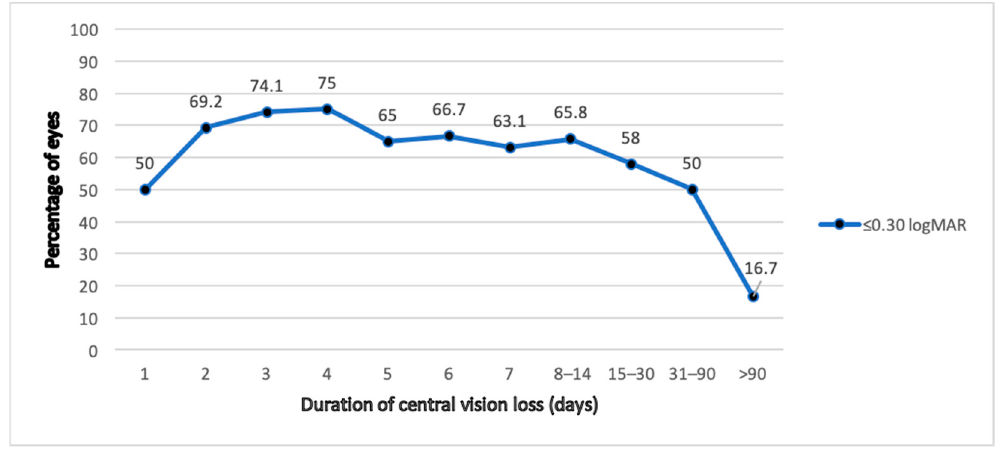
Figure 1. Relation between duration of central vision loss and percentage of eyes with final visual acuity of ≤ 0.30 logMAR, in non-recurrent macula-off RD.